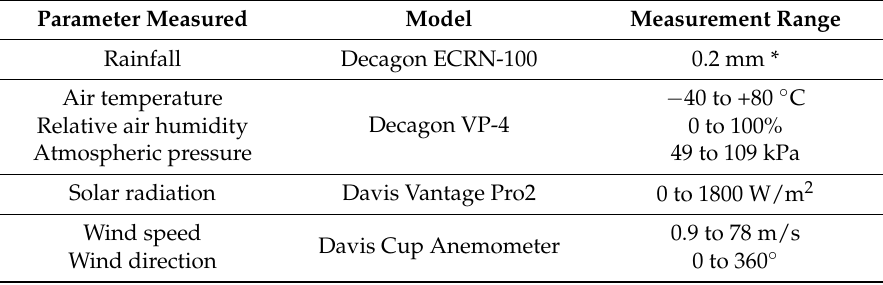
Table 3. Sensors installed at the meteorological station.